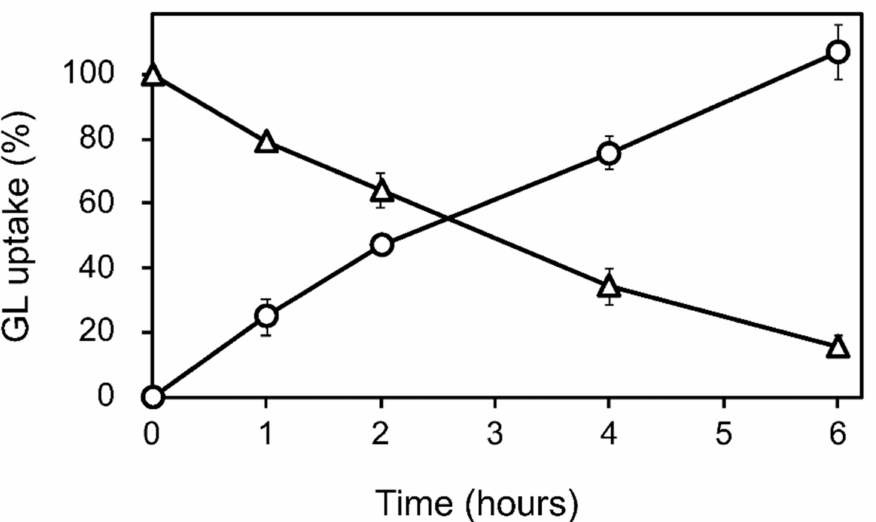
Figure 2. GL uptake by cultured cells of G. glabra . GL was added to the cultured cells at a concen- tration of 100 µ M. Circles and triangles represent the contents of GL in the cell and the medium, respectively. The value of 100% indicates the complete uptake amounts of GL added to the medium. Data are presented as the mean ± standard deviation from triplicate